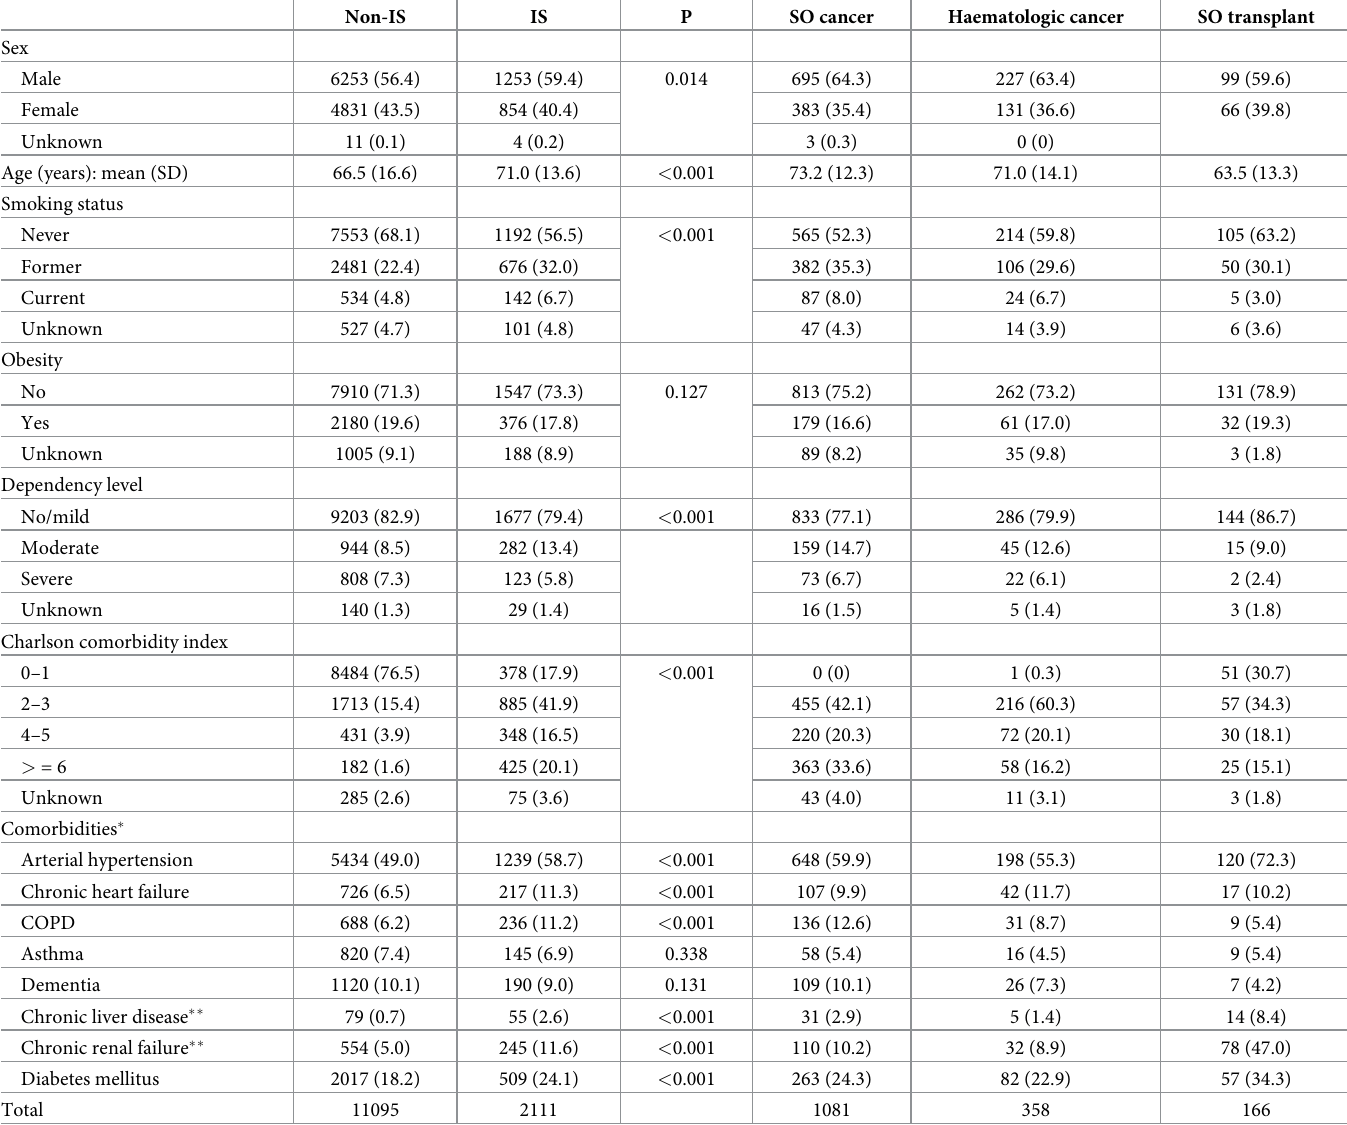
Table 1. Baseline demographic and clinical characteristics of the patients according to immune status, and of patients with solid organ cancer, haematologic cancer and solid organ transplant. Non-IS IS SO